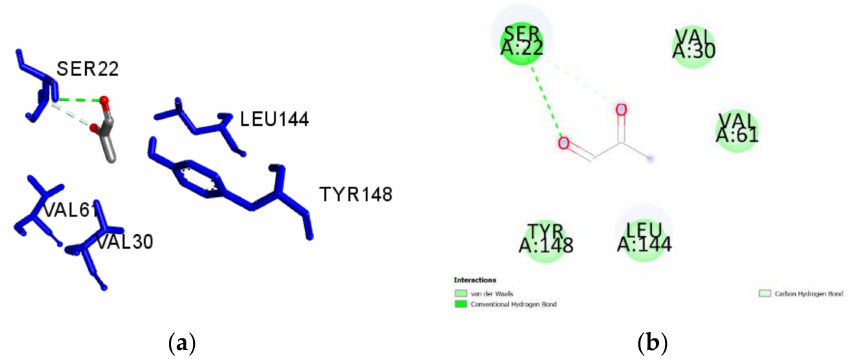
Figure 4. ( a ) Docked pose of 5-methyl-3-furancarboxylic acid in the Pa DsbA1 binding site showing molecular interactions—hydrogen and hydrophobic bonds shown as green and pink / purple dashed lines, respectively; ( b ) 2D plot of interactions between 5-methyl-3-furancarboxylic acid and key residues of Pa DsbA1 generated by BIOVIA Discovery Studio visualizer.